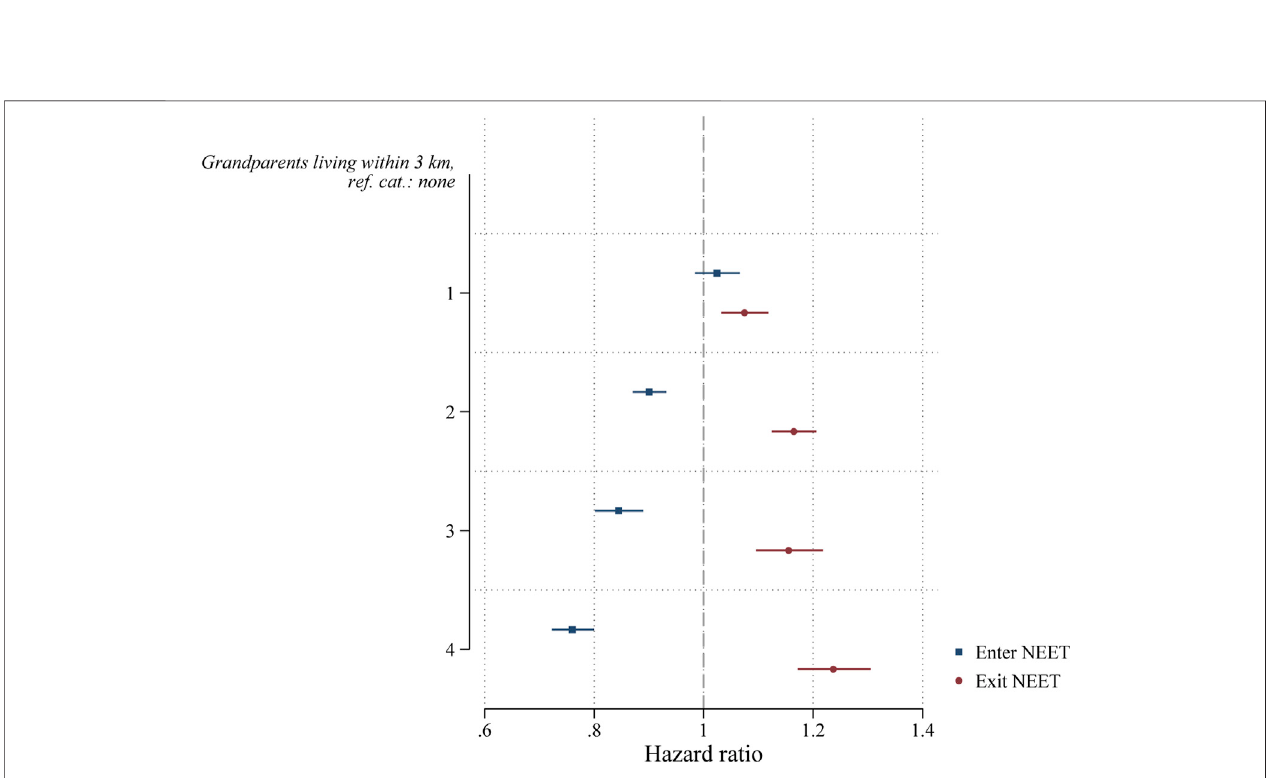
FIGURE 3 | Coef fi cients of grandparental availability within 3 km from discrete-time event-history analysis (hazard ratios) of entering and exiting NEET.